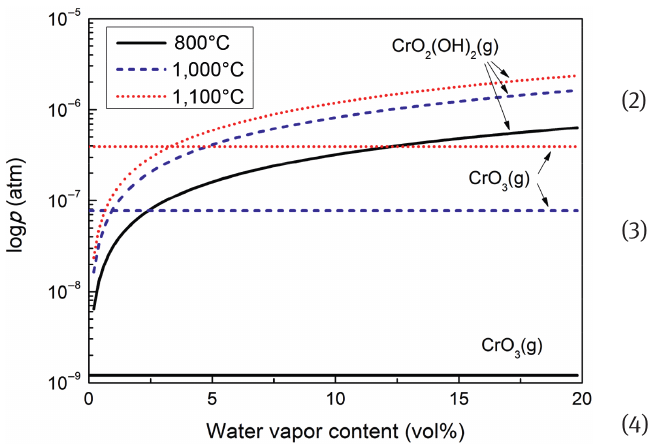
Figure 10: Equilibrium vapor pressures of CrO 3 and CrO 2 (OH) 2 at 1,000°C in air using thermodynamic data from [35,